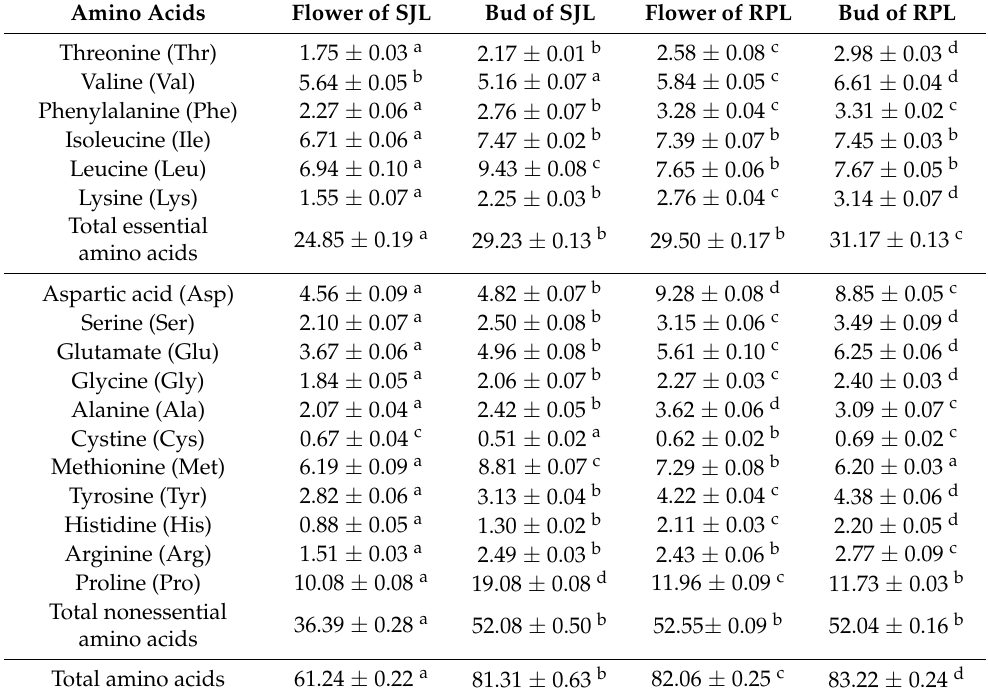
Table 3. Amino acid content of SJL and RPL (mg/g dw). Amino Acids Flower of SJL Bud of SJL Flower of RPL Bud of RPL Threonine